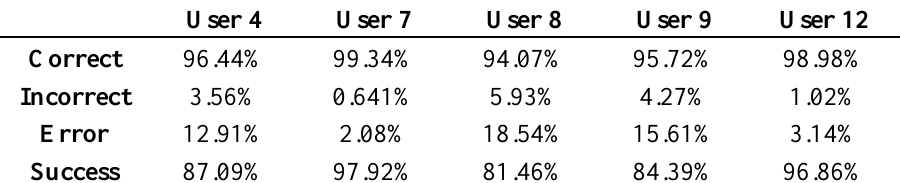
Table 14. SCR average from Stroop